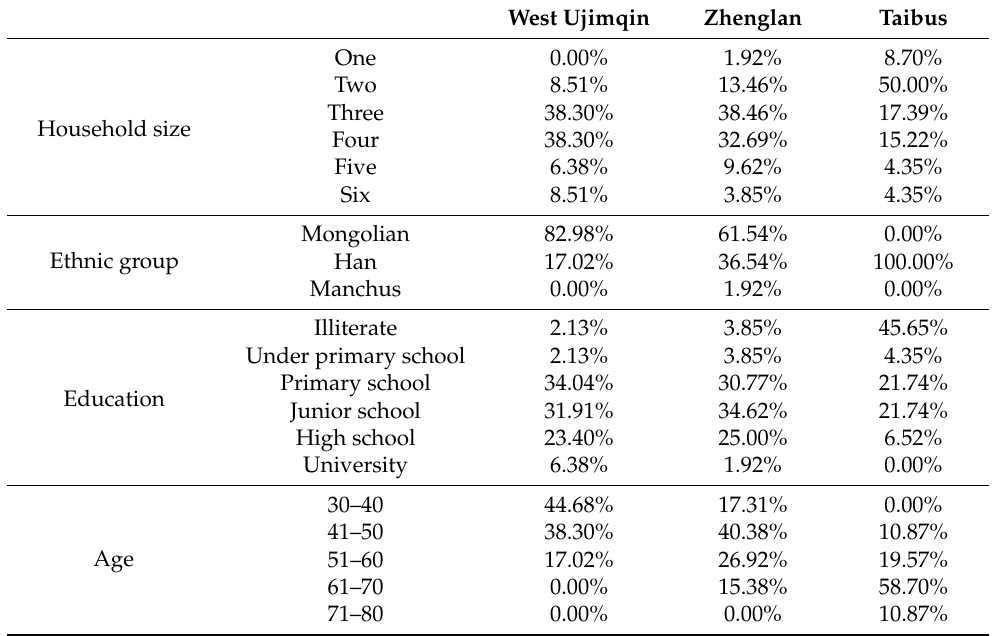
Table 1. Demographic information of survey